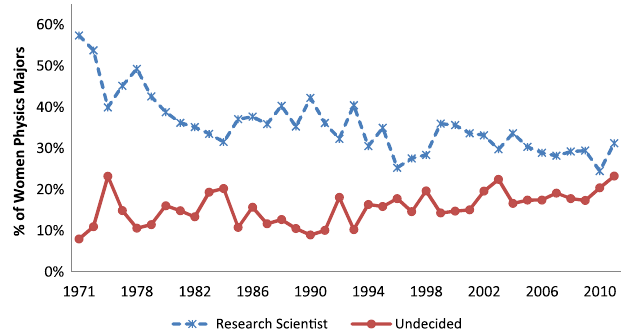
FIG. 3. The shifting career choices of female aspiring physics majors from 1971